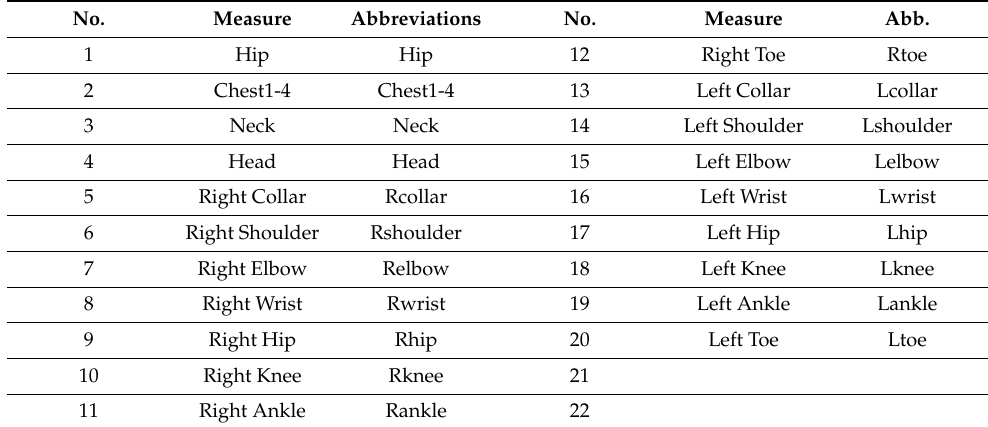
Table 2. Calculated Measures.